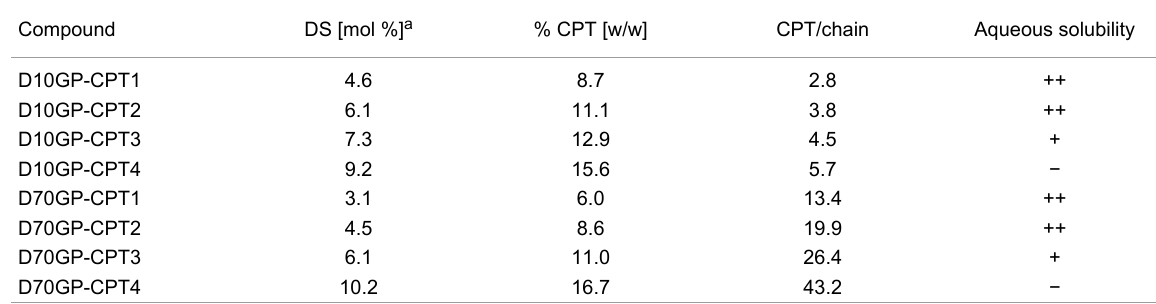
Table 1: DS, CPT content, number of CPT units per chain and aqueous solubility of the synthesized ( S )-camptothecin-dextrans.